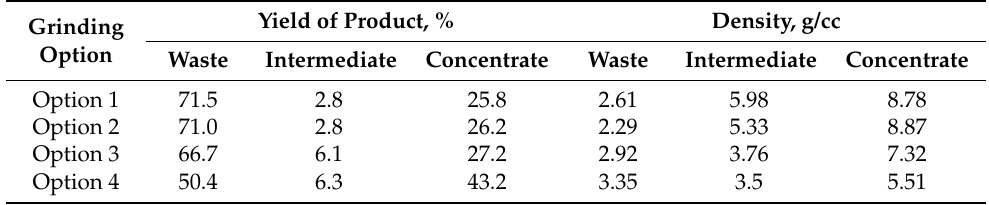
Table 2. Yield and density of electrostatic separation